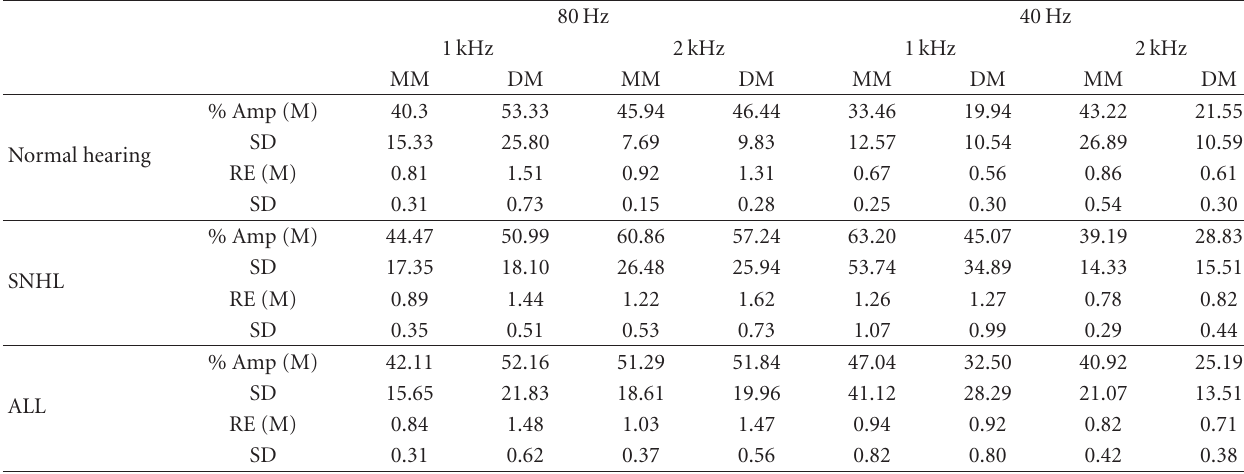
Table 2: Percent amplitude and relative e ffi